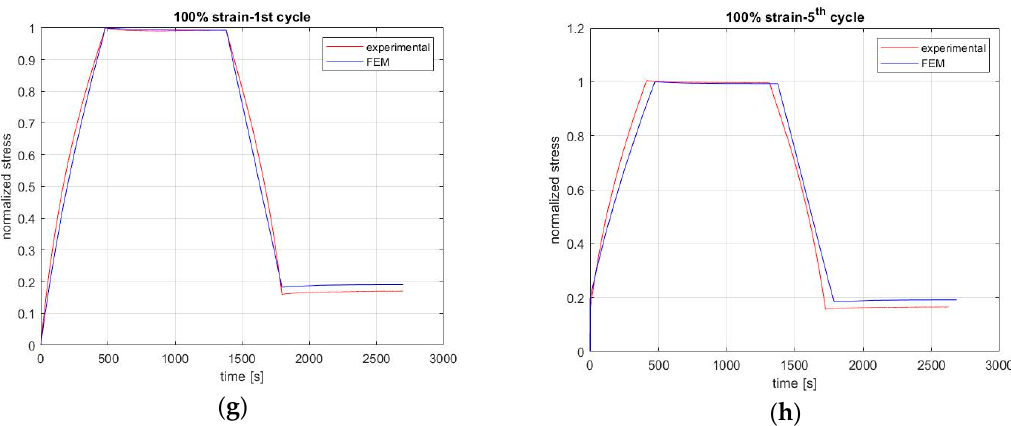
Figure 6. The normalized stress response following the application and removal of strain as a step function of time during the first cycle (left column) for the strain levels of ( a ) 25%, ( c ) 50%, ( e ) 75%, ( g ) 100% and fifth cycle (right column) for the strain levels of ( b ) 25%, ( d ) 50%, ( f ) 75%, ( h ) 100%.